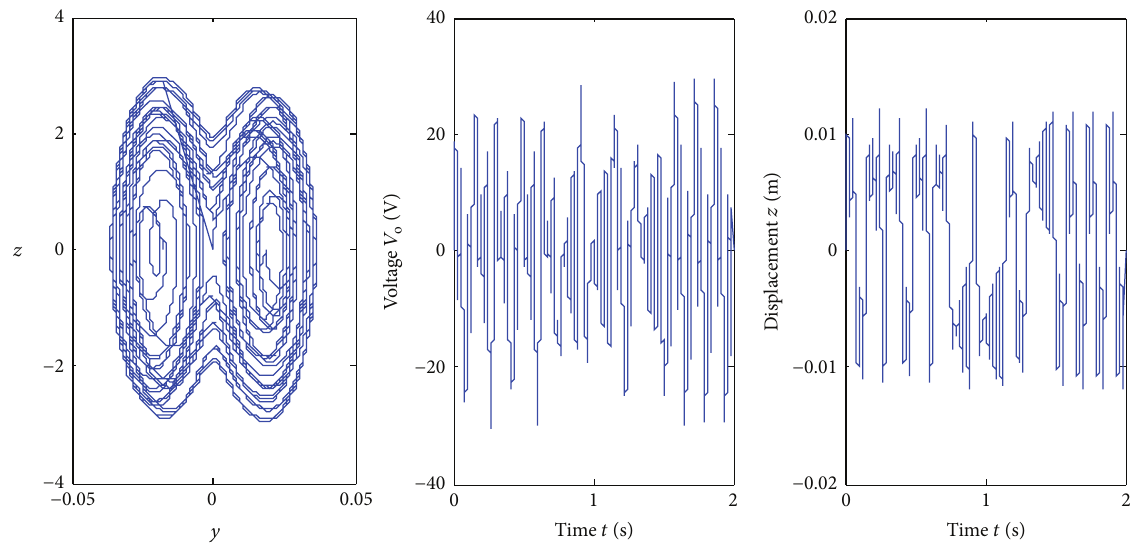
Figure 9: A homoclinic bifurcation and chaotic motion when 𝑓 = 21 Hz.